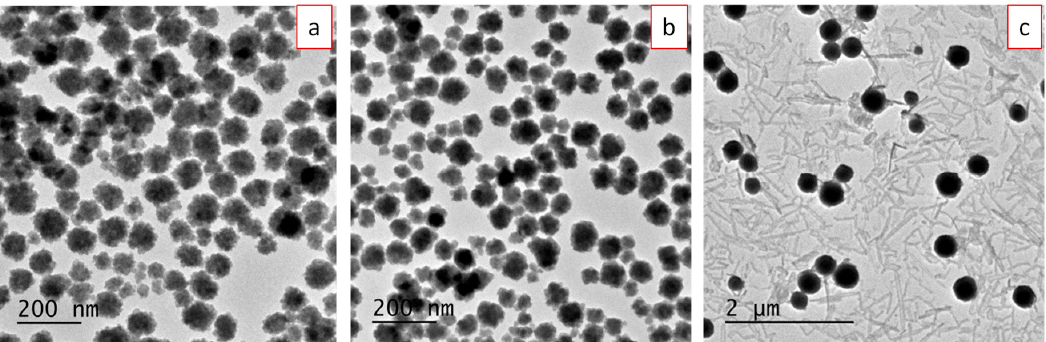
Figure 4. TEM micrographs of precipitates observed after treating, at 50 °C for 15 h, EG/H 2 O (90/10) solutions containing NaBF 4 (0.18 M) and different Lu(NO 3 ) 3 ·6H 2 O contents: 0.05 M ( a ), 0.1 M ( b ), and 0.5 M ( c ).